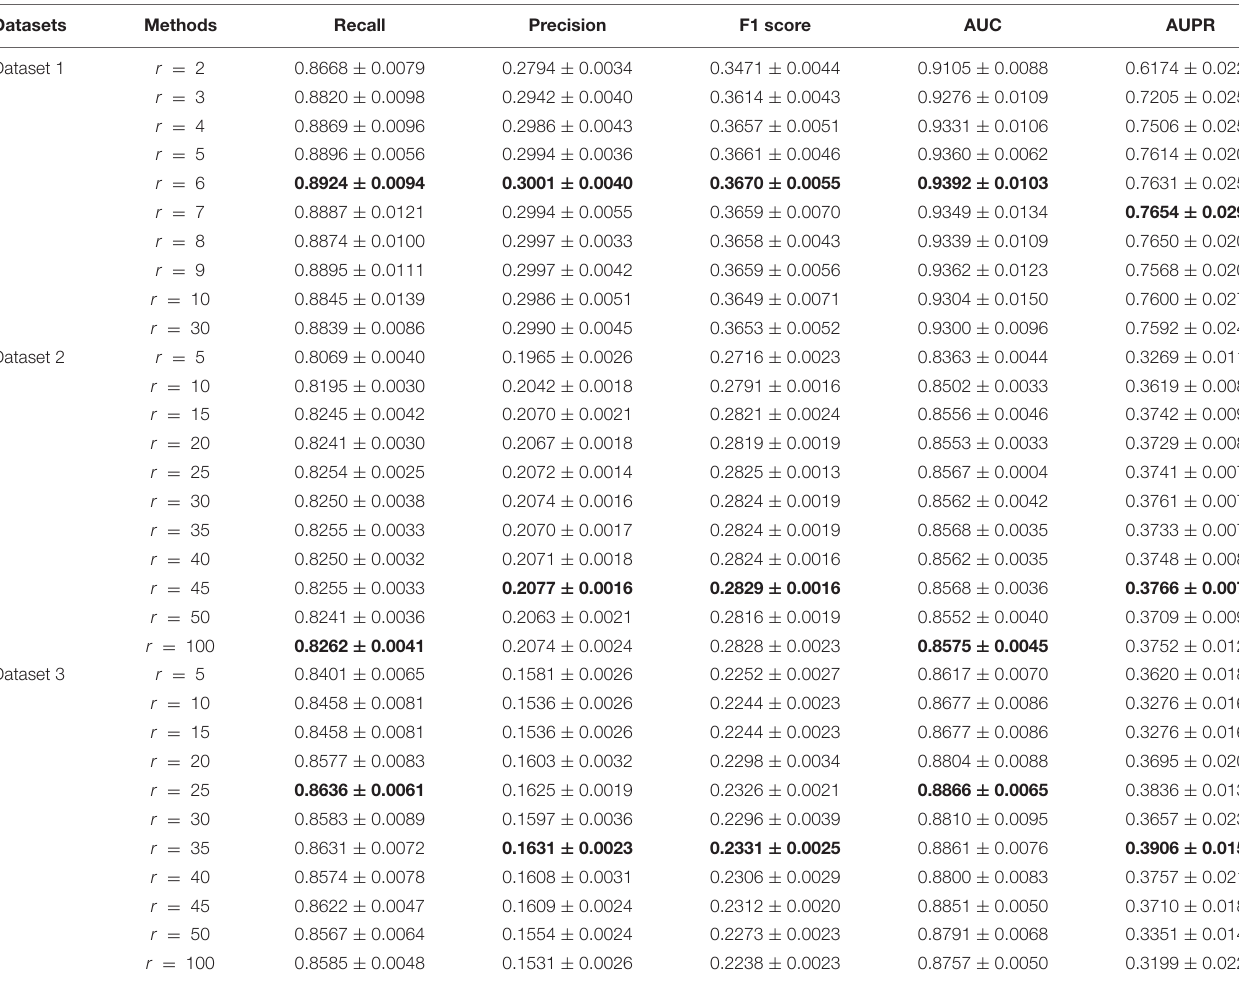
TABLE 6 | The effect of different r on VDA-KLMF on three datasets under